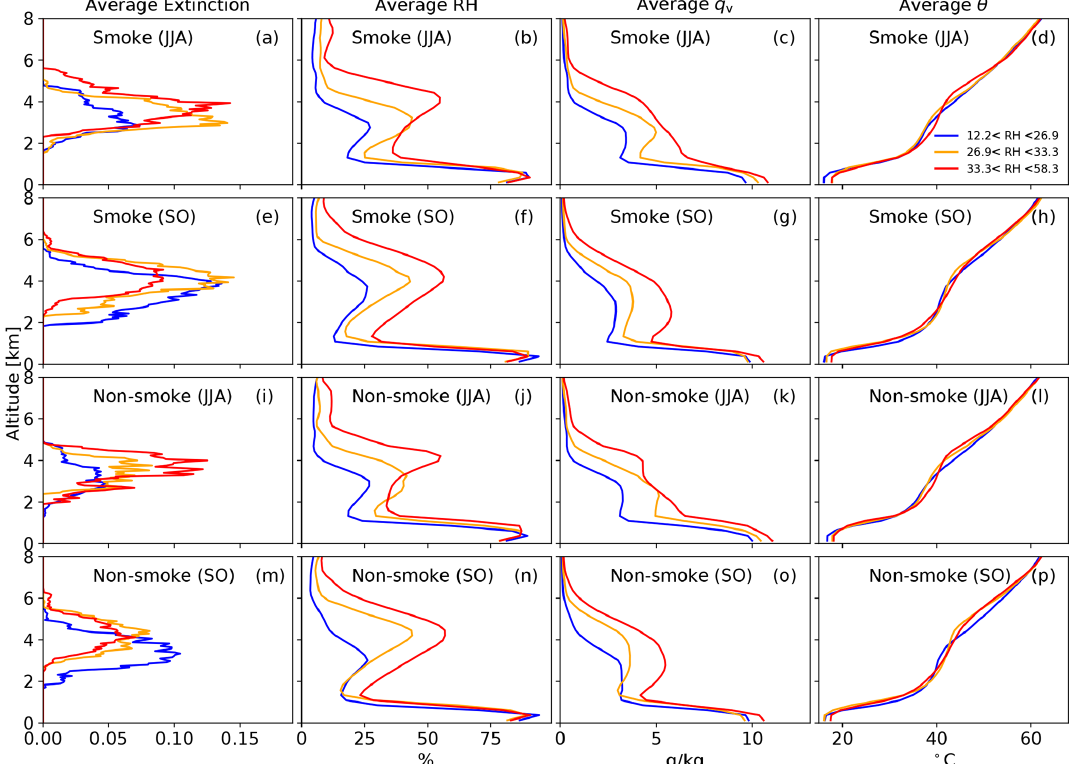
Figure A2. Mean profiles of aerosol extinction, relative humidity (RH), specific humidity ( q v ), and potential temperature ( θ ) for the smoke cases June–July–August (JJA) and September–October (SO). Cases here subdivided into three intervals depending on the RH value. RH, q v , and θ values are derived from variables in the CloudSat ECMWF-AUX